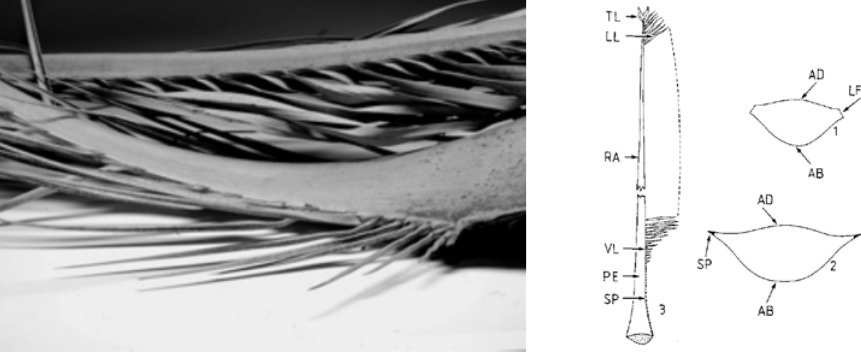
Figure1. Photographs and Caption of the form of palm fronds